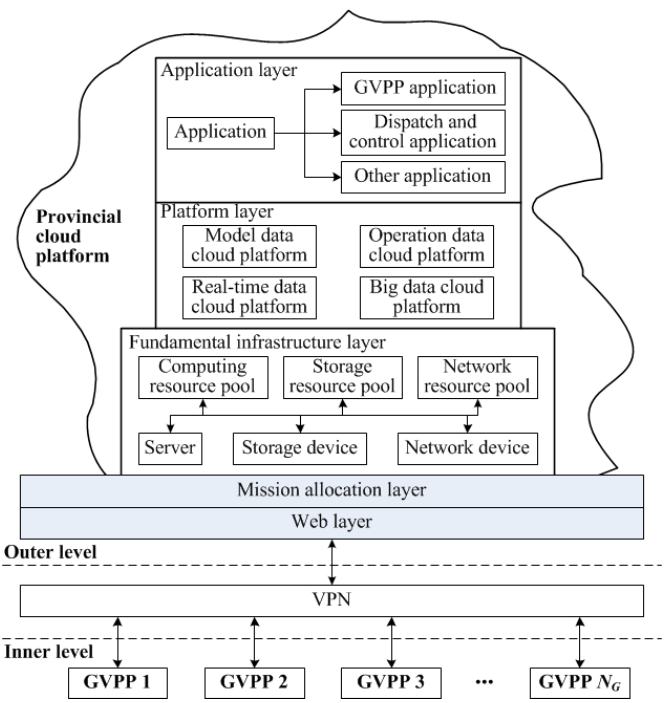
Figure 9. Bi-level dispatch and control architecture of GVPPs based on the cloud platform.